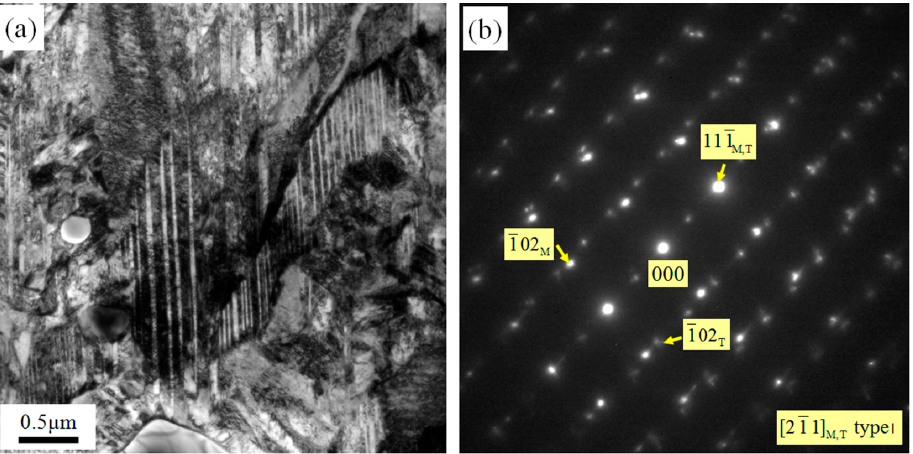
Figure 4. TEM micrographs of Ni-50 at % Ti SMA: ( a ) bright field image; ( b ) diffraction pattern of ( a ).